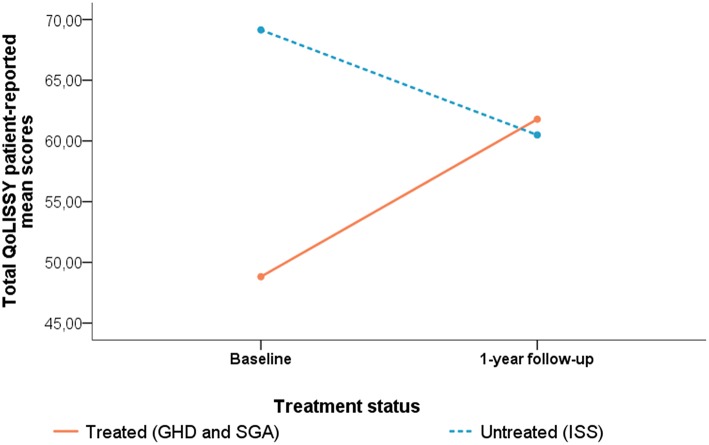
Changes in patient-reported QoLISSY Total score from baseline to 1-year after start of hGH treatment for the intervention group (patients with IGHD and SGA) and comparison group (untreated patients with ISS). Two-factorial repeated measurement ANCOVA for the QoLISSY Total score. Covariates appearing in the model were evaluated at the following values: Age at baseline = 10.91 years; Time difference between baseline and 1-year follow-up = 12.74 months.